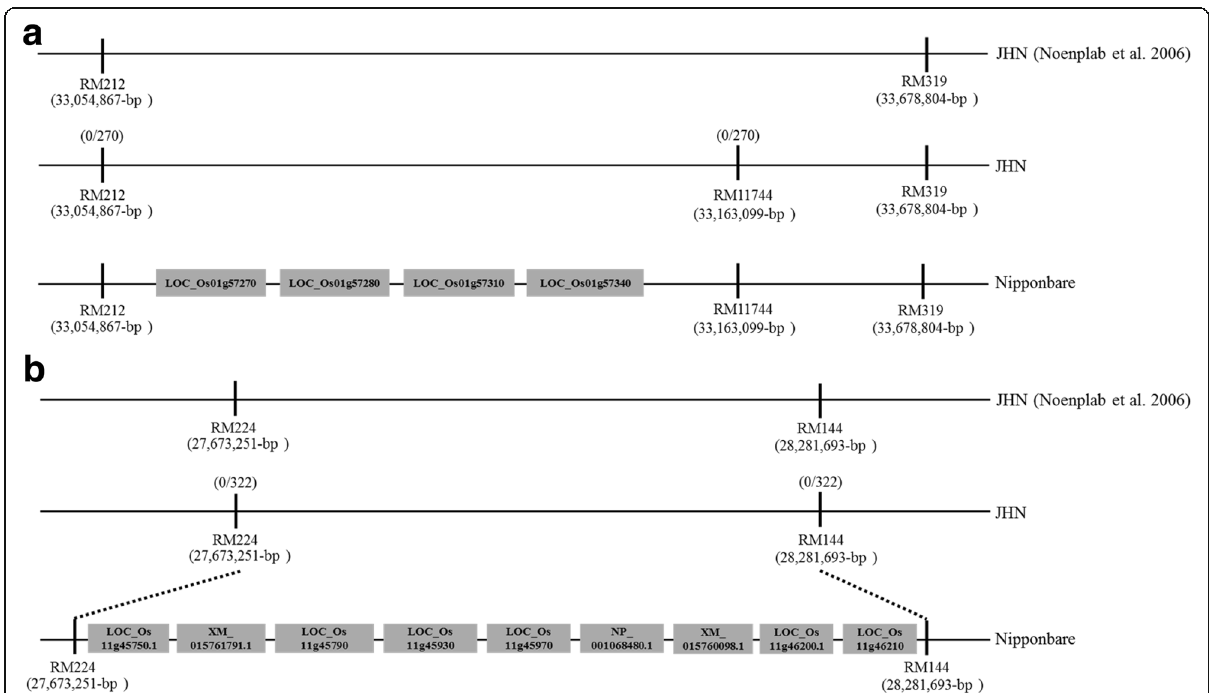
Fig. 2 An integrated genetic and physical map of QTL1 ( a ) and QTL2 ( b ). The chromosomal position of SSR markers delimiting the genomic interval of QTLs by referring to the one in the reference genome of Nipponbare was indicated below the line. The number of recombinants/toal F 3 progeny at each SSR marker was indicated above the line. Four and 9 NBS-LRR type R genes predicted in the genomic intervals in Nipponbare for QTL1 and QTL11, respectively, were indicated in boxes with gene IDs. The figure was not draw in scale